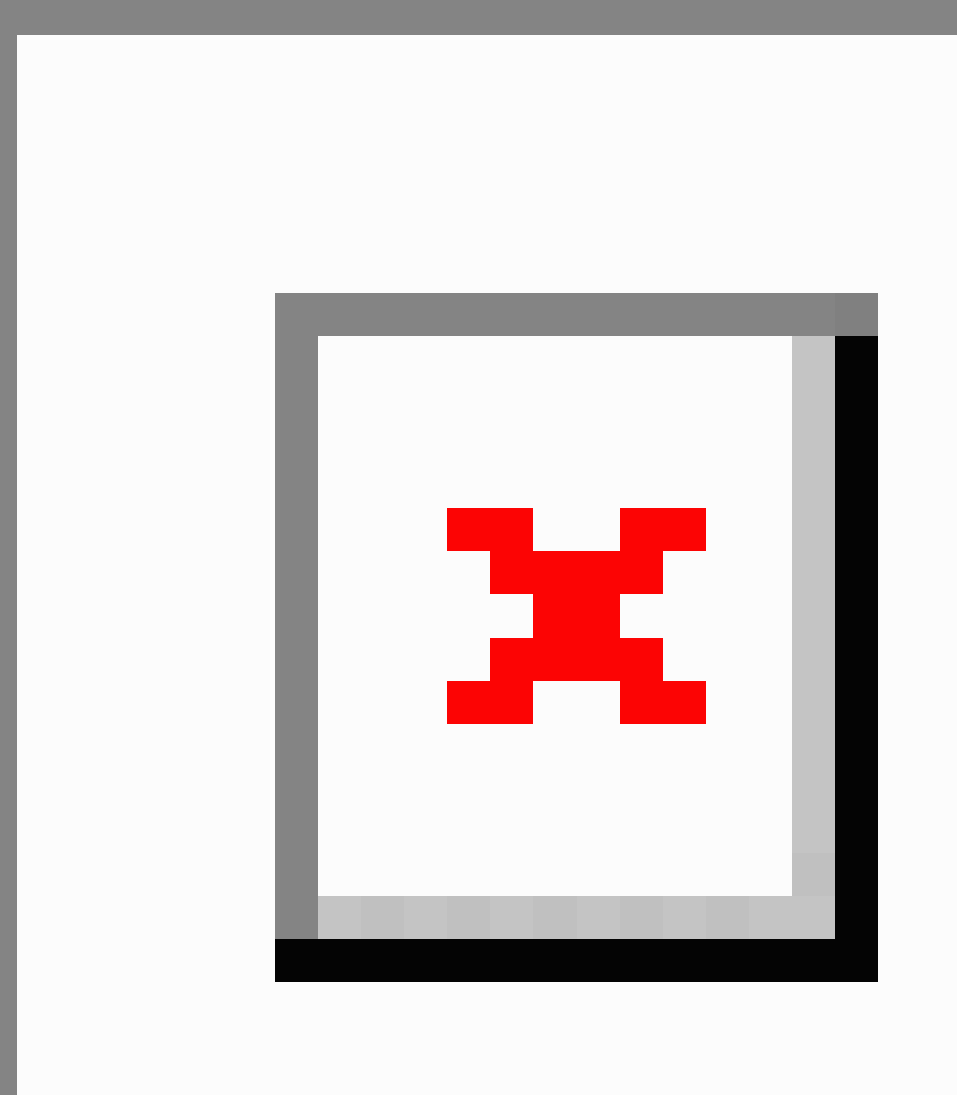
Figure 2. A cumulative case chart showing the number of cases of coronavirus